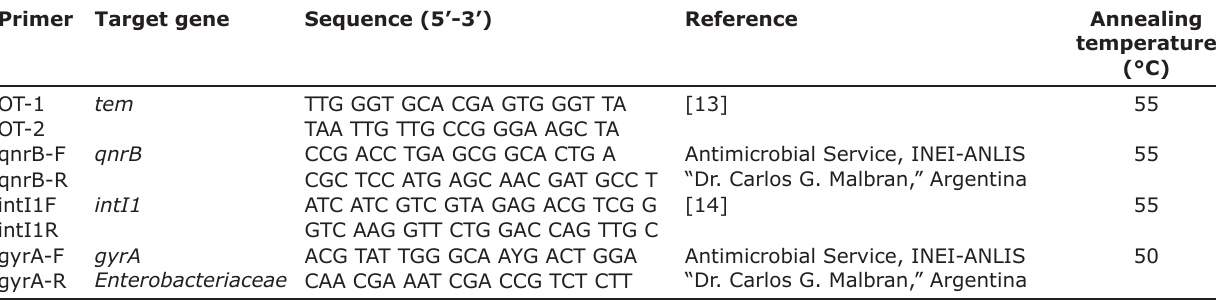
Table-1: Primers, annealing temperatures, and references for each target gene. Primer Target gene Sequence (5’-3’)